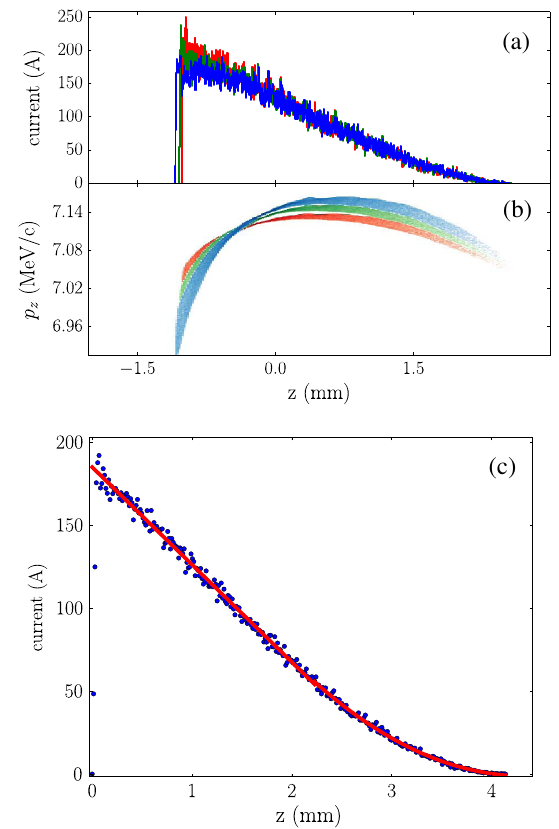
FIG. 5. Evolution of the electron-bunch current (a) and longi- tudinal phase space (b) along the beam line at 20 (red), 60 (green), and 100 cm (blue) from the photocathode surface and (c) comparison of the current profile numerically simulated at s ¼ 50 cm (blue symbols) with a fit to Eq. (13) (red line). The head of the bunch is at large values of z